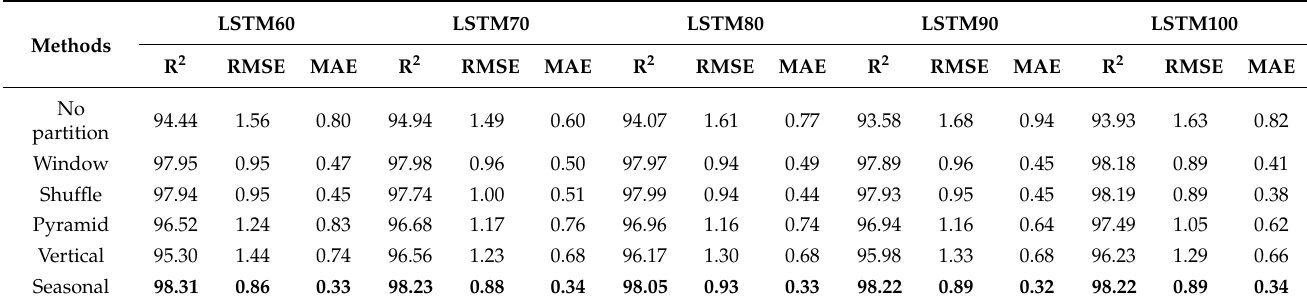
Table 6. Experimental results of hourly forecasting of Site